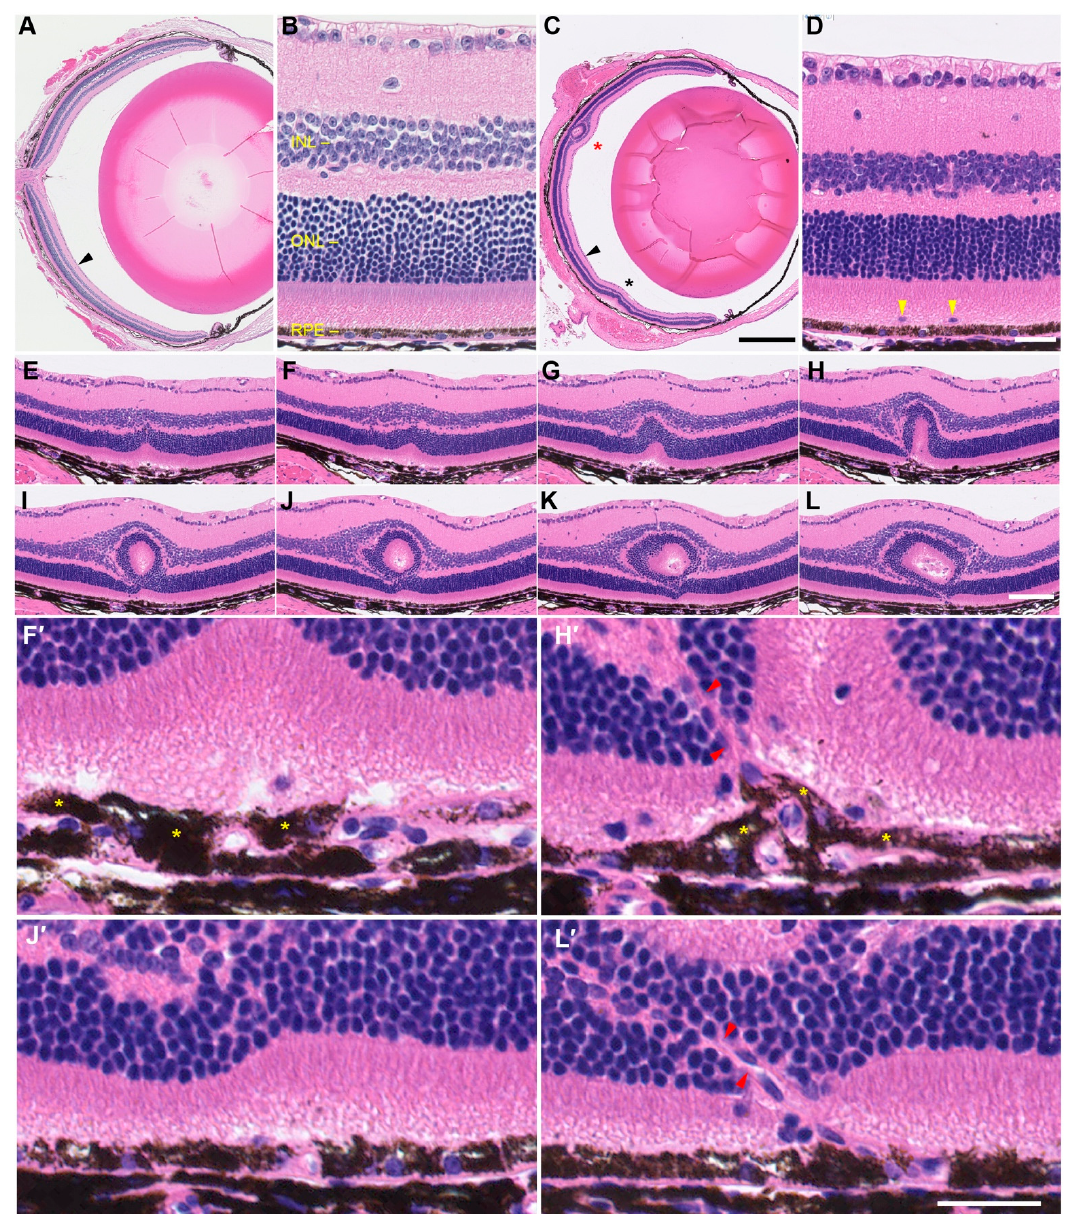
Figure 5. Hematoxylin- and eosin-stained ocular sections of control (n = 4) and tvrm77 mice (n = 4) at 2 months of age. ( A ) B6 eye. ( B ) Detail of ( A ), arrowhead, indicating normal lamination. GCL, ganglion cell layer; INL, inner nuclear layer; ONL, outer nuclear layer; RPE, retinal pigment epithelium. ( C ) tvrm77 eye. Retinal folds, asterisks. Scale bar, 500 µm, also applies to panel ( A ). ( D ) Detail of ( C ), arrowhead, showing normal retinal layers and RPE morphology. Subretinal ectopic nuclei, yellow arrowheads. Scale bar, 25 µm, also applies to panel ( B ). ( E – L ) Serial analysis of a retinal fold and neovascular lesions corresponding to C , red asterisk. Every fourth section obtained by sectioning is shown, corresponding to a spacing of 20 µm between the sections shown. Scale bar in ( L ), 100 µm, applies to panels ( E – L ). ( F ′ , H ′ , J ′ , L ′ ) Detail of panels ( F , H , J , L ). RPE layer doubling, yellow asterisks. Independent neovascular structures through the ONL ( H (cid:48) , L (cid:48) , red arrowheads) are part of the same lesion. ( H (cid:48) ) Scale bar, 25 µ m, applies to panels ( F (cid:48) , H (cid:48) , J (cid:48) , L (cid:48) )